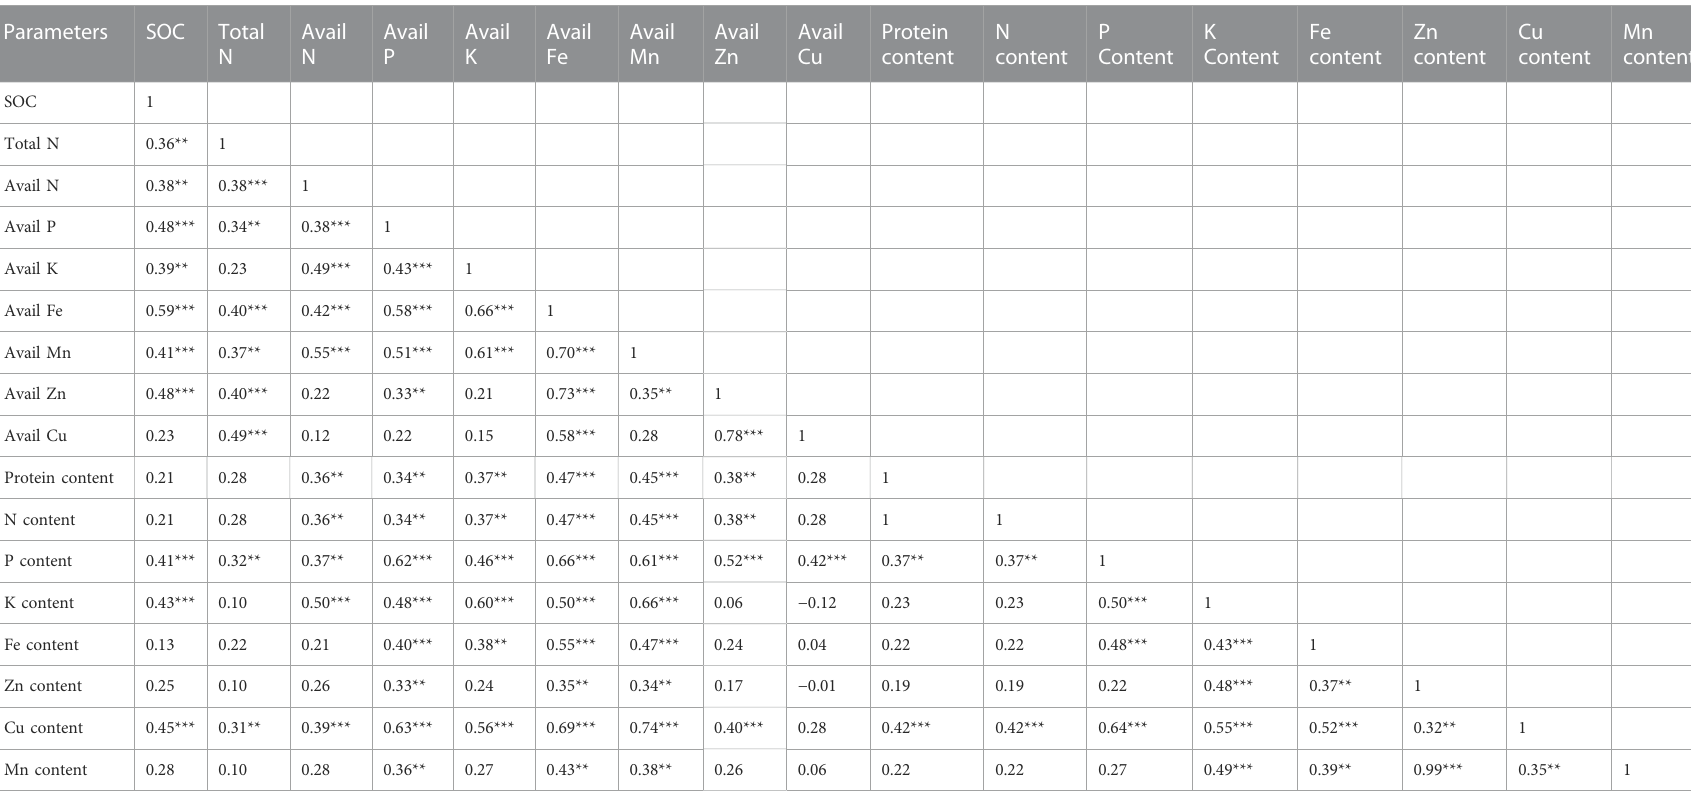
TABLE 6 Correlation matrix of different soil (SOC, total N and available N, P, K, Fe, Mn, Zn, and Cu) and grain quality (protein content and N, P, K, Fe, Zn, Cu, and Mn contents) parameters under different cropping systems and nutrient management treatments.